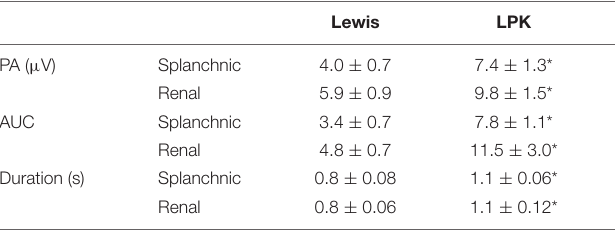
TABLE 2 | RespSNA parameters in splanchnic and renal nerves in adult female Lewis and LPK rats under baseline conditions.